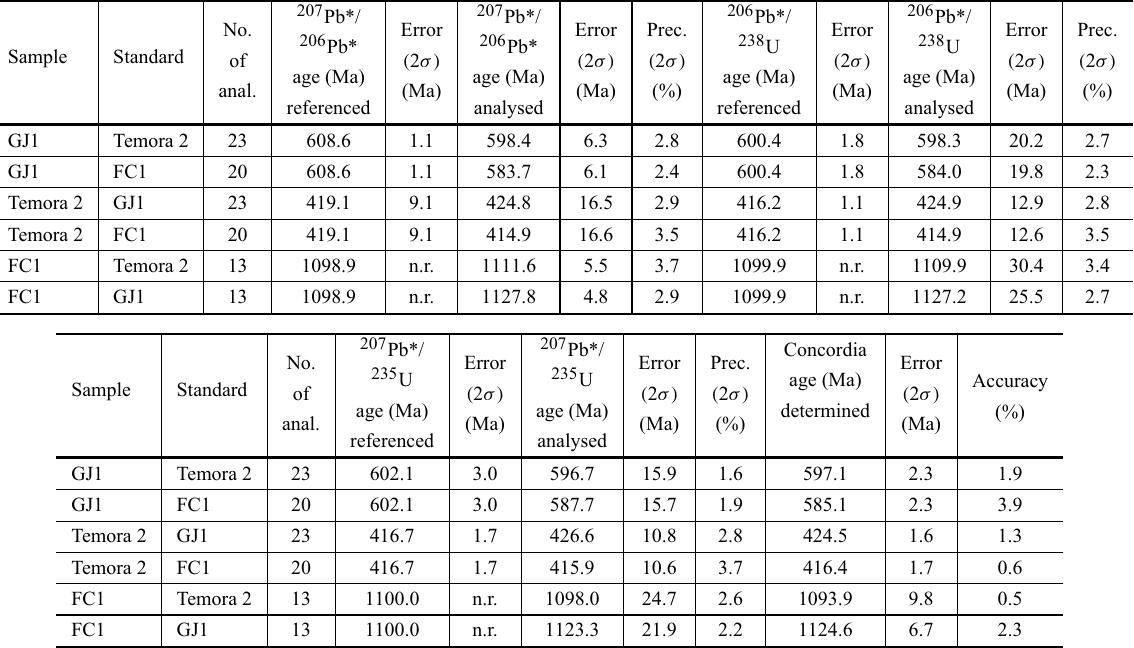
Referenced and determined ages (by LA-ICP-MS) of the zircon standards GJ1, Temora 2 and